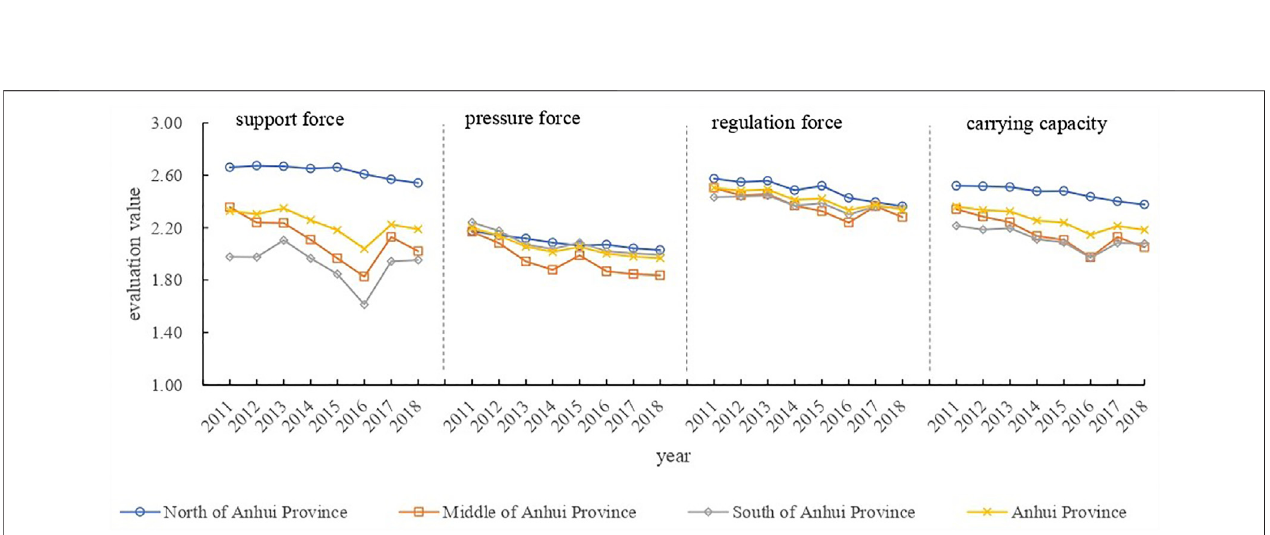
FIGURE 7 | Change trend of water resources carrying capacity in Anhui Province and its subregions.